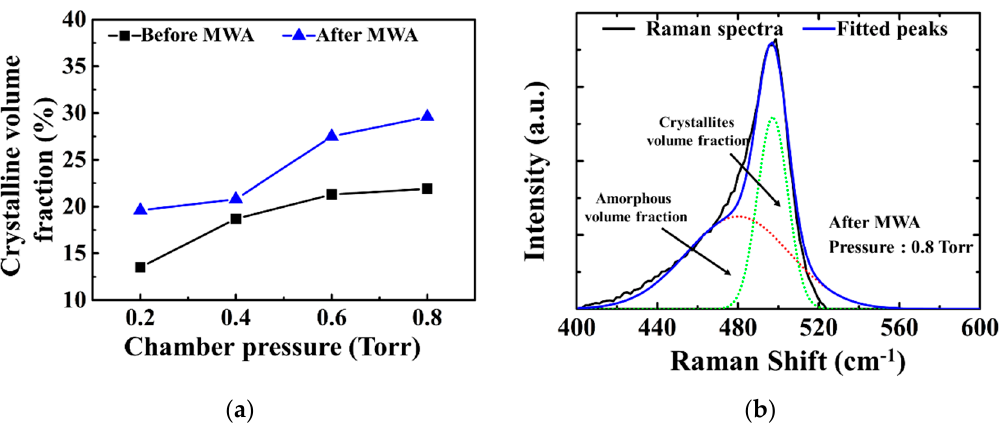
Figure 6. ( a ) The crystalline volume fraction of the deposited nc-Si:H as a function of chamber pressures before and after treating with MWA. ( b ) Deconvoluted Raman spectra after treating with MWA of nc-Si:H deposited on the glass substrate at a chamber pressure of 0.8 Torr. In all cases, the power density was 40 mW/cm 2 , the substrate temperature was 150 °C, and the H 2 /SiH 4 flow was 50 sccm.